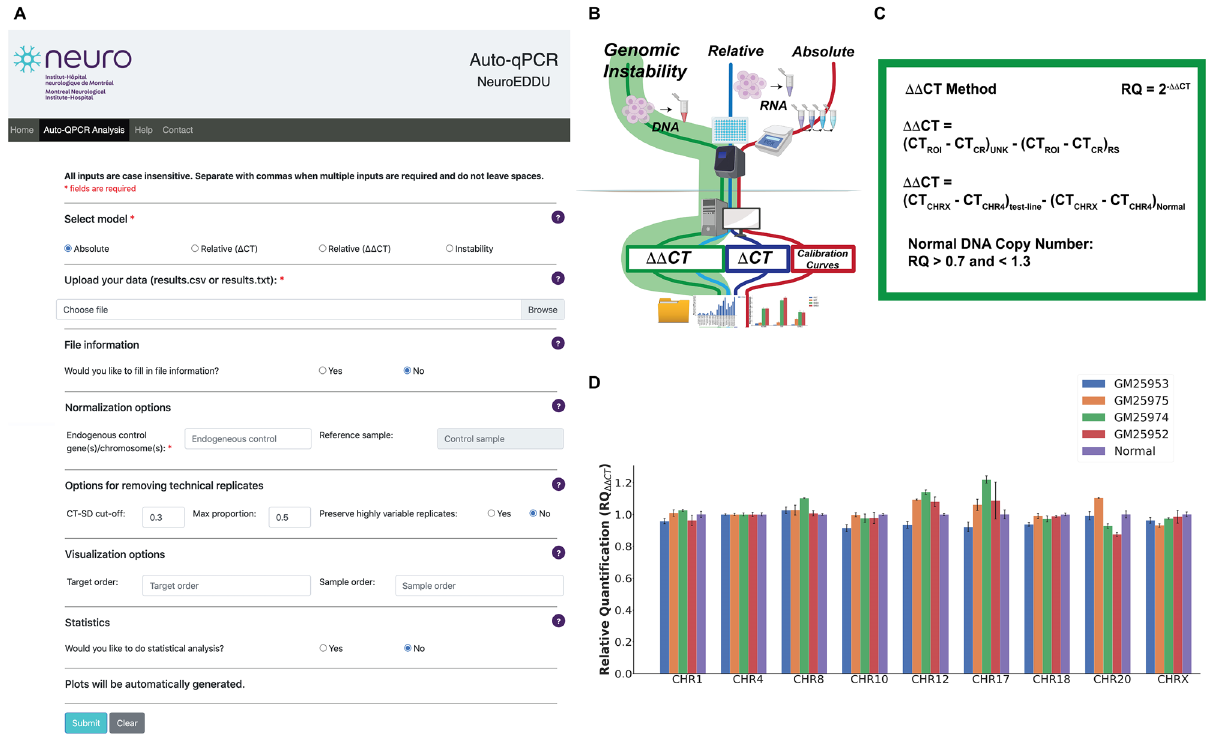
Figure 2. Auto-qPCR can process PCR genomic stability data. ( A ) Screen capture of the Auto-qPCR web-app. ( B ) Simplified schematic of PCR workflow showing the genomic instability analysis in green. The DNA copy number is quantified with the same formula as the ΔΔ CT relative quantification model. ( C ) The calculations carried out for genomic instability testing (ΔΔ CT). Top, the general formula used where the CT values for each chromosome were normalized to a region of interest and then to a reference sample. Middle, the reference DNA region (CHR4) and the reference sample (Normal) used in this dataset. Bottom, the confidence interval for determining a genomic instability, insertion, or deletion event. ( D ) Bar chart showing the output from Auto-qPCR program running the genomic instability model. Four different iPSC cell lines are indicated and compared to the control sample. Normalized signals for all four cell lines are in the confidence interval defined by the control